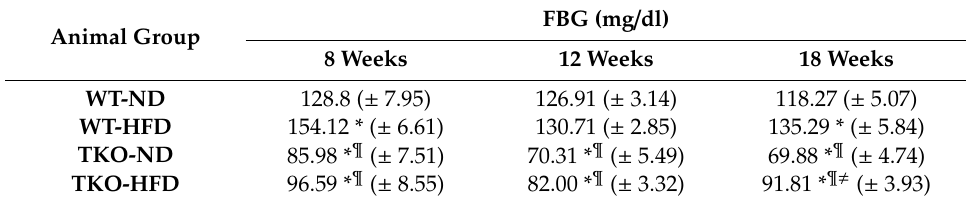
Table 1. Summary of the fasting blood glucose (FBG) levels of all animal groups. (Data are represented as mean ± SEM, n = 11–19 / group; * p -value < 0.05 vs. WT-ND, and ¶ vs. WT-HFD), (cid:44) vs. TKO-ND. Animal